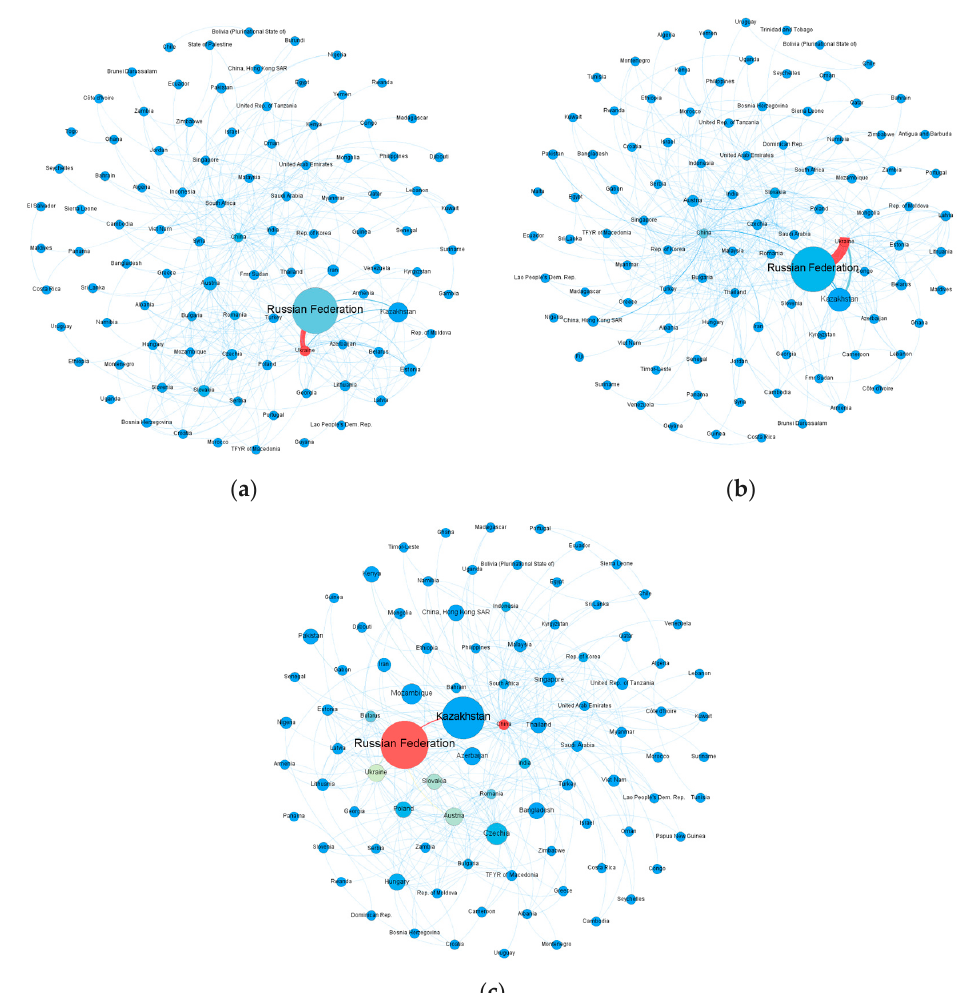
Figure A2. Trade networks of not self-propelled coaches and vans products in the BRI region. ( a ) phase 1 (2003–2008), ( b ) phase 2 (2009–2013), ( c ) phase 3 (2014–2017). The settings are the same as in Figure 7.